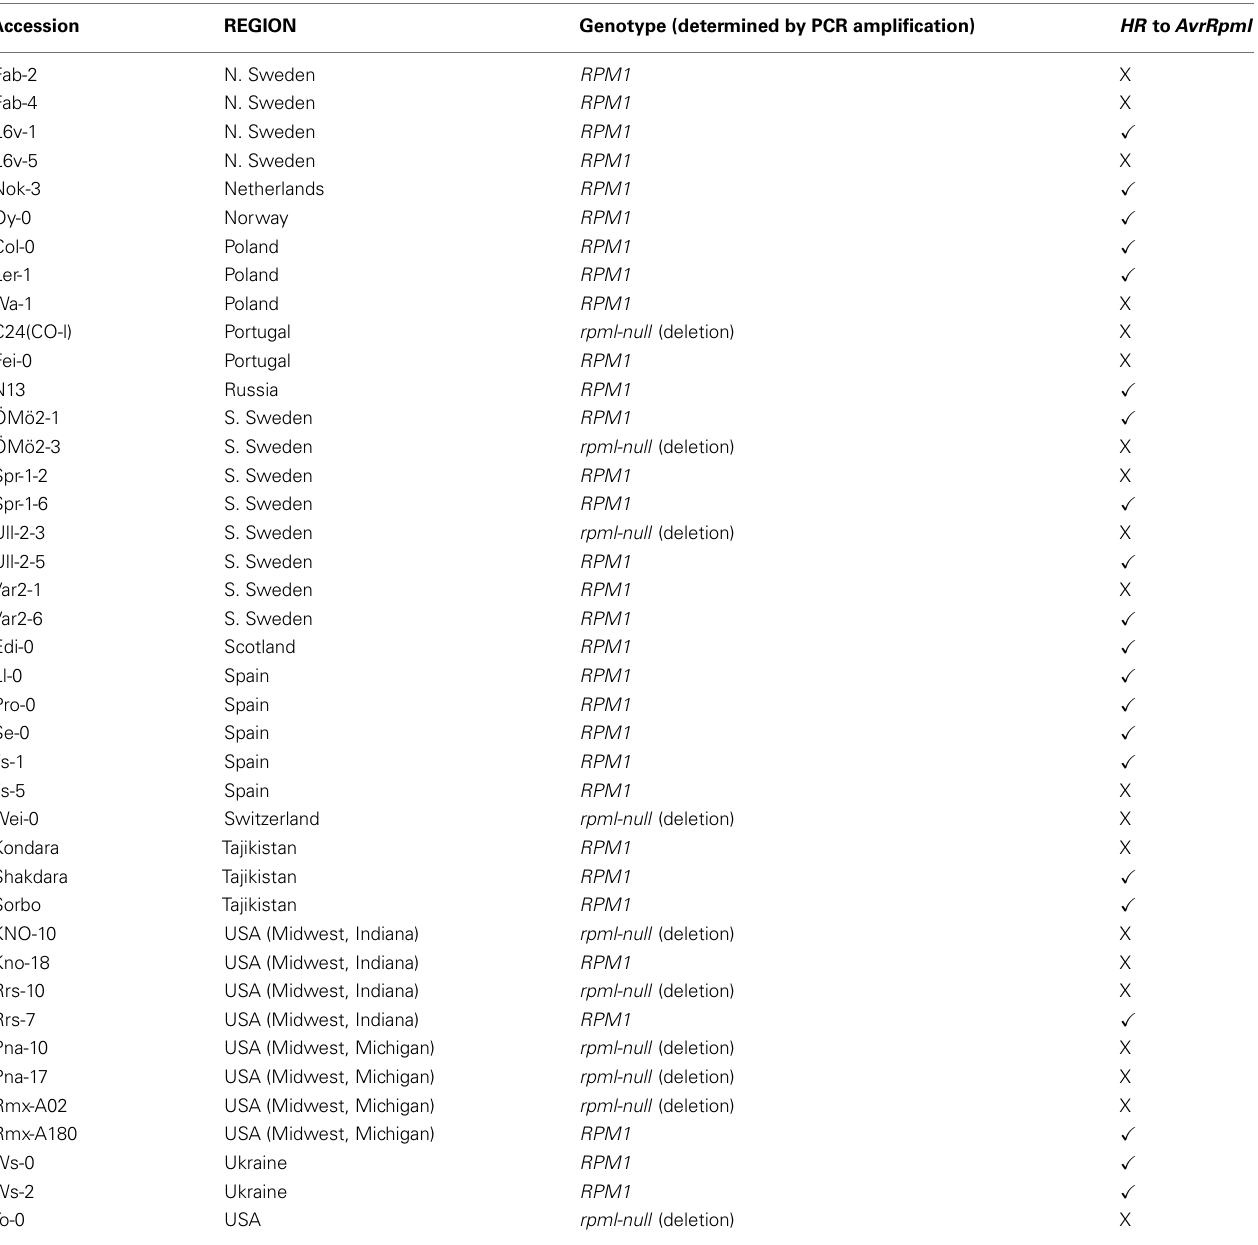
TableA3 | Survey of sequence variation at RPM1 in worldwide sample using diagnostic markers.